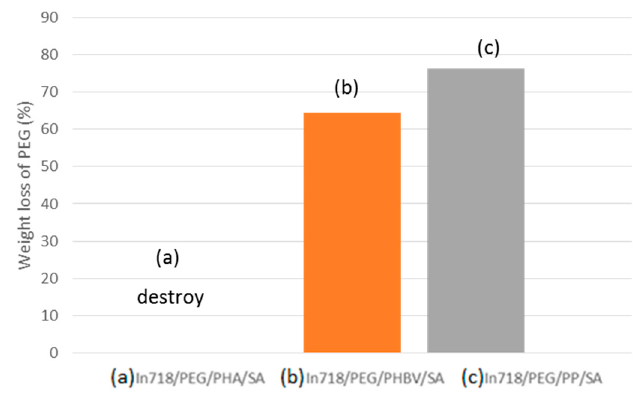
Figure 7. Weight loss of PEG for the different feedstocks after supercritical CO 2 debinding process at 150 °C and 400 bar during 4 h.